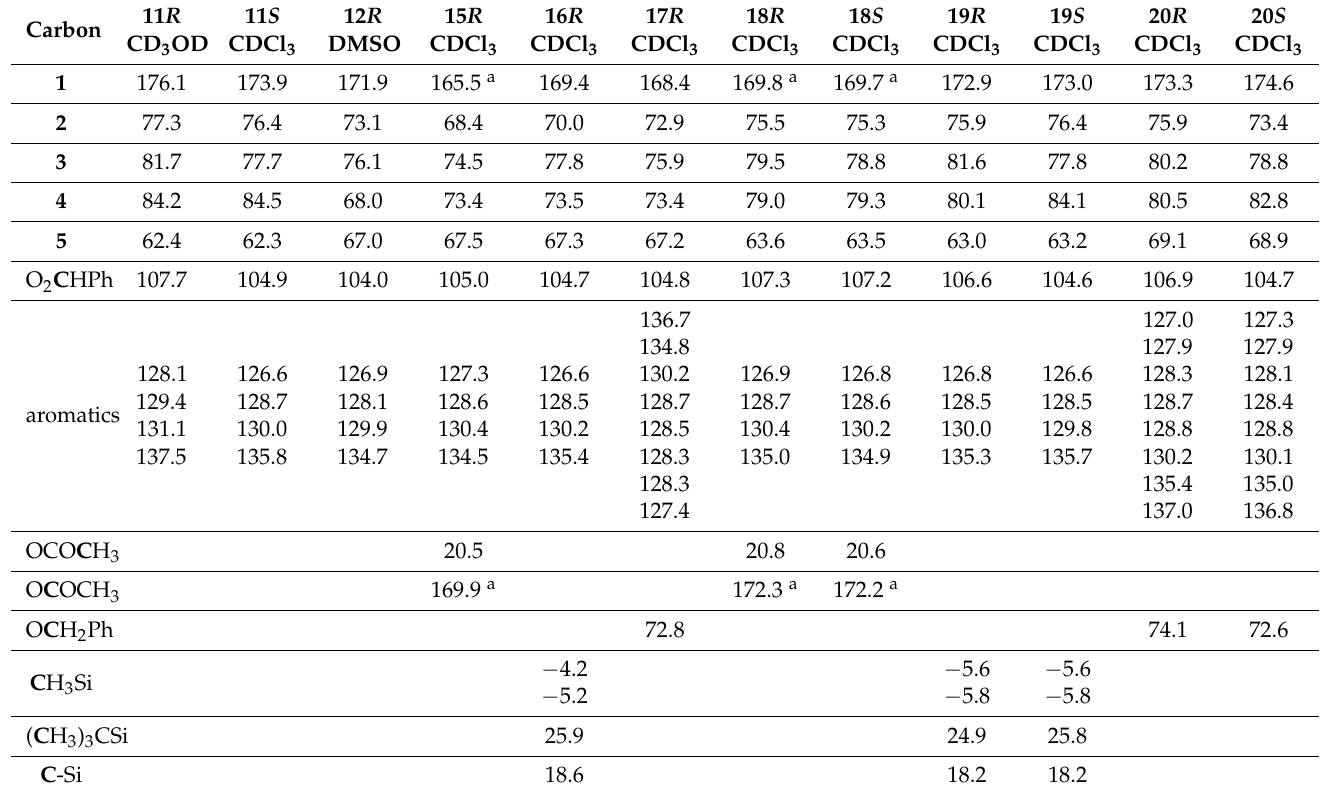
Table 2. 13 C NMR chemical shifts (ppm) of R and S epimers of 11 , 18 – 20 and R epimers of 12 , 15 –